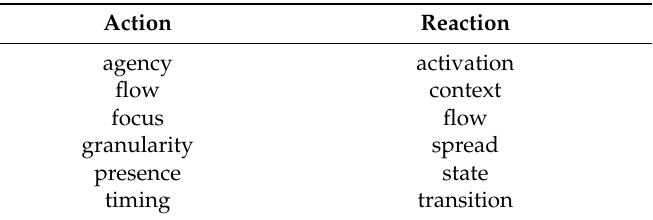
Table 1. Elements of Interaction in the INFORM